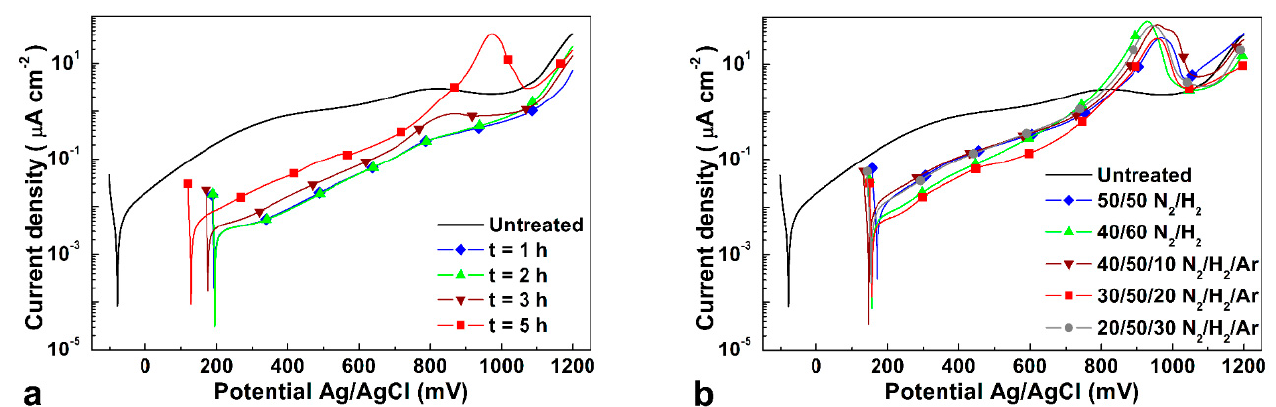
Figure 12. Polarization curves of samples untreated, and nitrided at 360 ( a ) and 380 ( b ) °C as indicated.